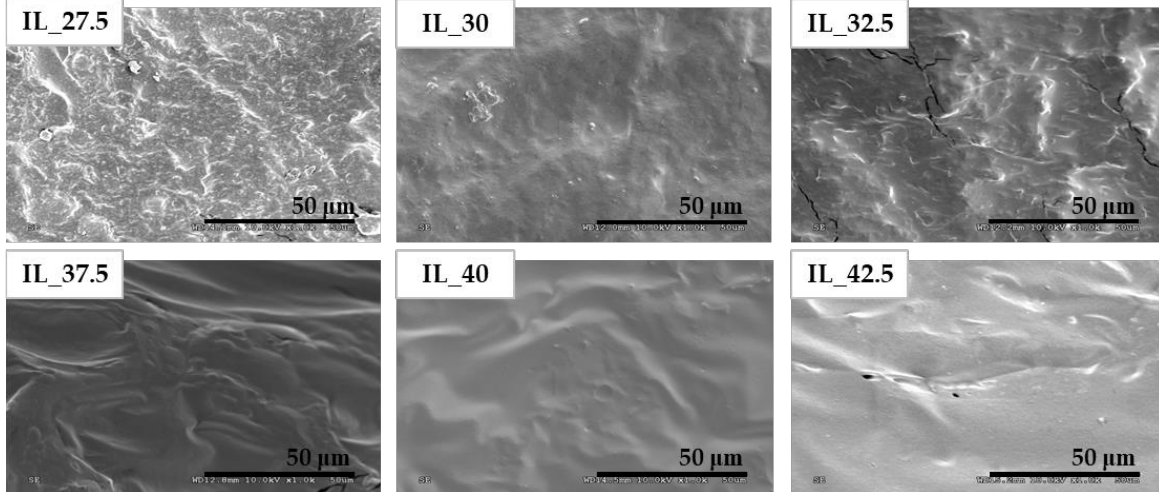
Figure 2. SEM images of the cryogenic fracture surface of sheets (magnification 1000×).